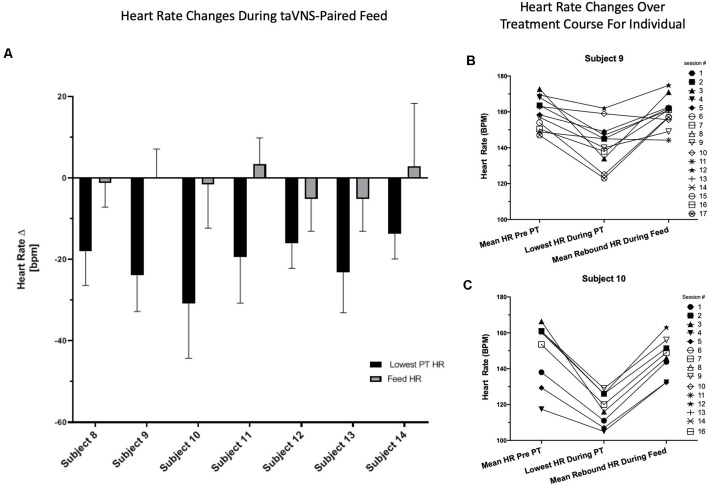
Reproducibility and reliability of individual HR change. (A) Individual HR change from baseline with onset of stimulation and during taVNS -paired feeding by individual subject. HR is averaged over all taVNS-paired feedings for each individual subject. (B,C) HR data from individual treatment sessions in two representative participants. HR changes are shown for each individual taVNS-paired feeding session over 5 min before and during taVNS-paired feedings and the lowest HR recorded during onset of stimulation with PT determination.